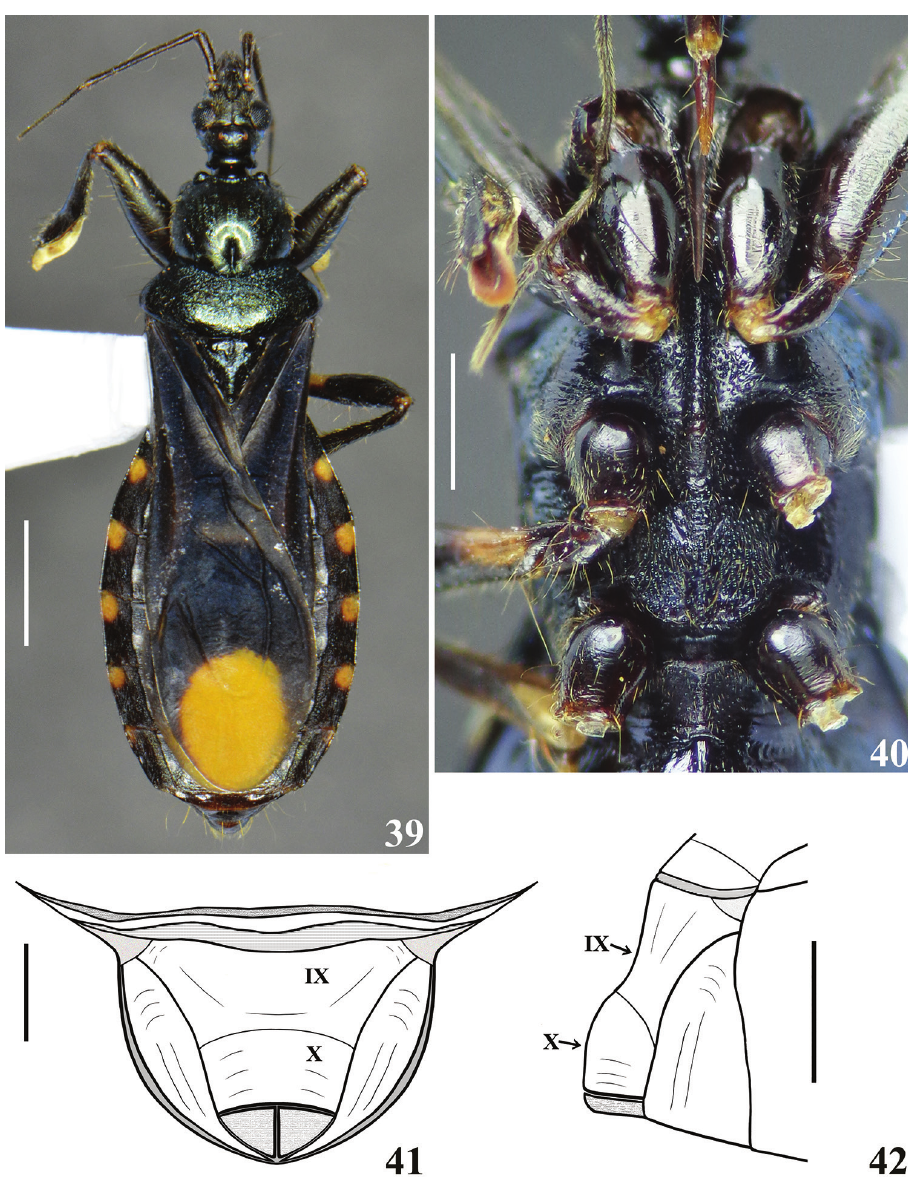
Figures 39–42. Zeraikia zeraikae sp. n., female paratype. 39 dorsal view 40 thorax, ventral view 41–42 female genitalia 41 posterior view 42 lateral view. ( IX tergite IX; X tergite X). Scale bars: 2.0 mm ( 39 ); 1.0 mm ( 40 ); 0.5 mm ( 41–42